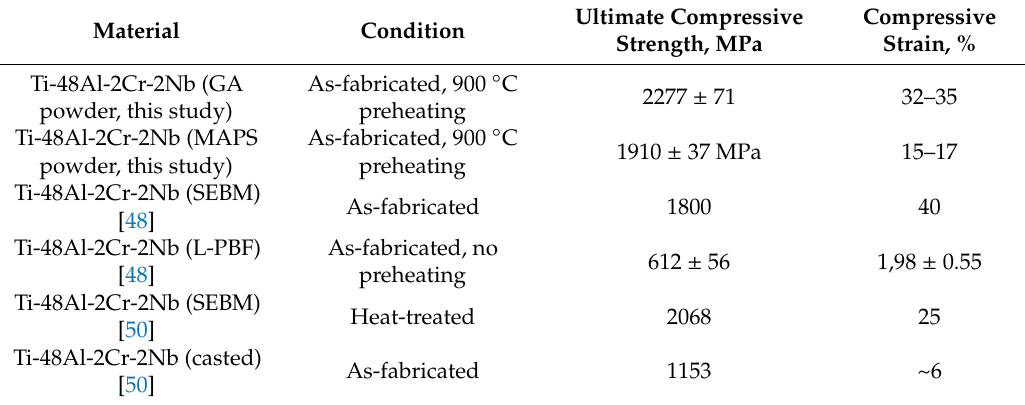
Table 5. Comparison of room temperature mechanical properties of TiAl alloy manufactured by di ff erent